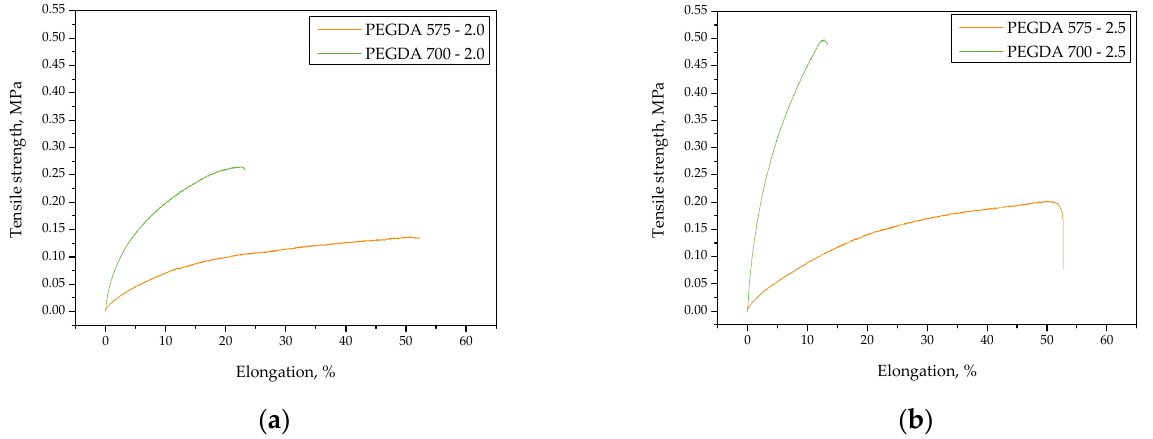
Figure 1. Stress–strains curves of hydrogels obtained using 2.0 mL ( a ) and 2.5 mL ( b ) of crosslinking agent with various average molecular weights.